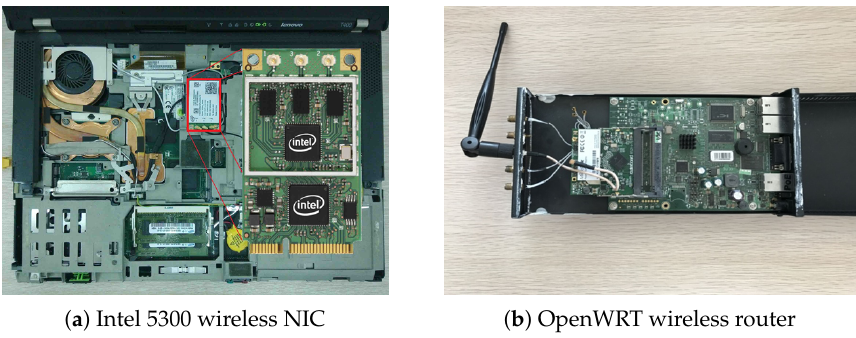
Figure 10. Experimental